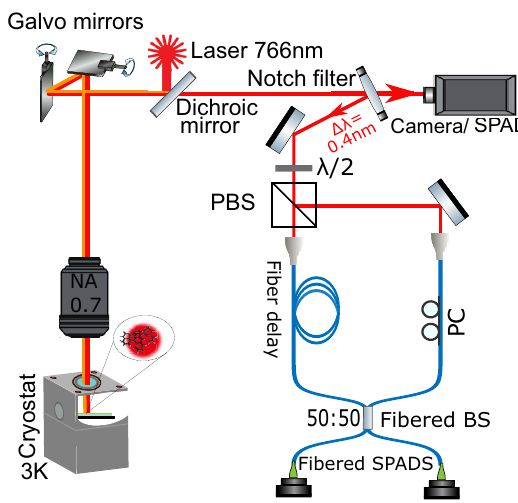
Figure 1. Experimental Setup: A Picoquant laser is used, which can be operated both in pulsed and CW mode. DBT:Ac NCs are kept inside a cryostat at 3K. An epi-fluorescence microscope with 0.7-N.A. objective is employed for excitation and emission col- lection. Notch Filter with 0.4-nm window filters the ZPL from the phonon side band (PSB). Different possible delay lines and a fibered beam splitter (BS) are used in the interferometer. EMCCD Camera and a free-space-coupled single photon avalanche diode (SPAD) are used to anaylize the ZPL and the PSB, whereas Fibered SPADs and a time to digital converter allow for reconstructing the histogram of the relative photon arrival